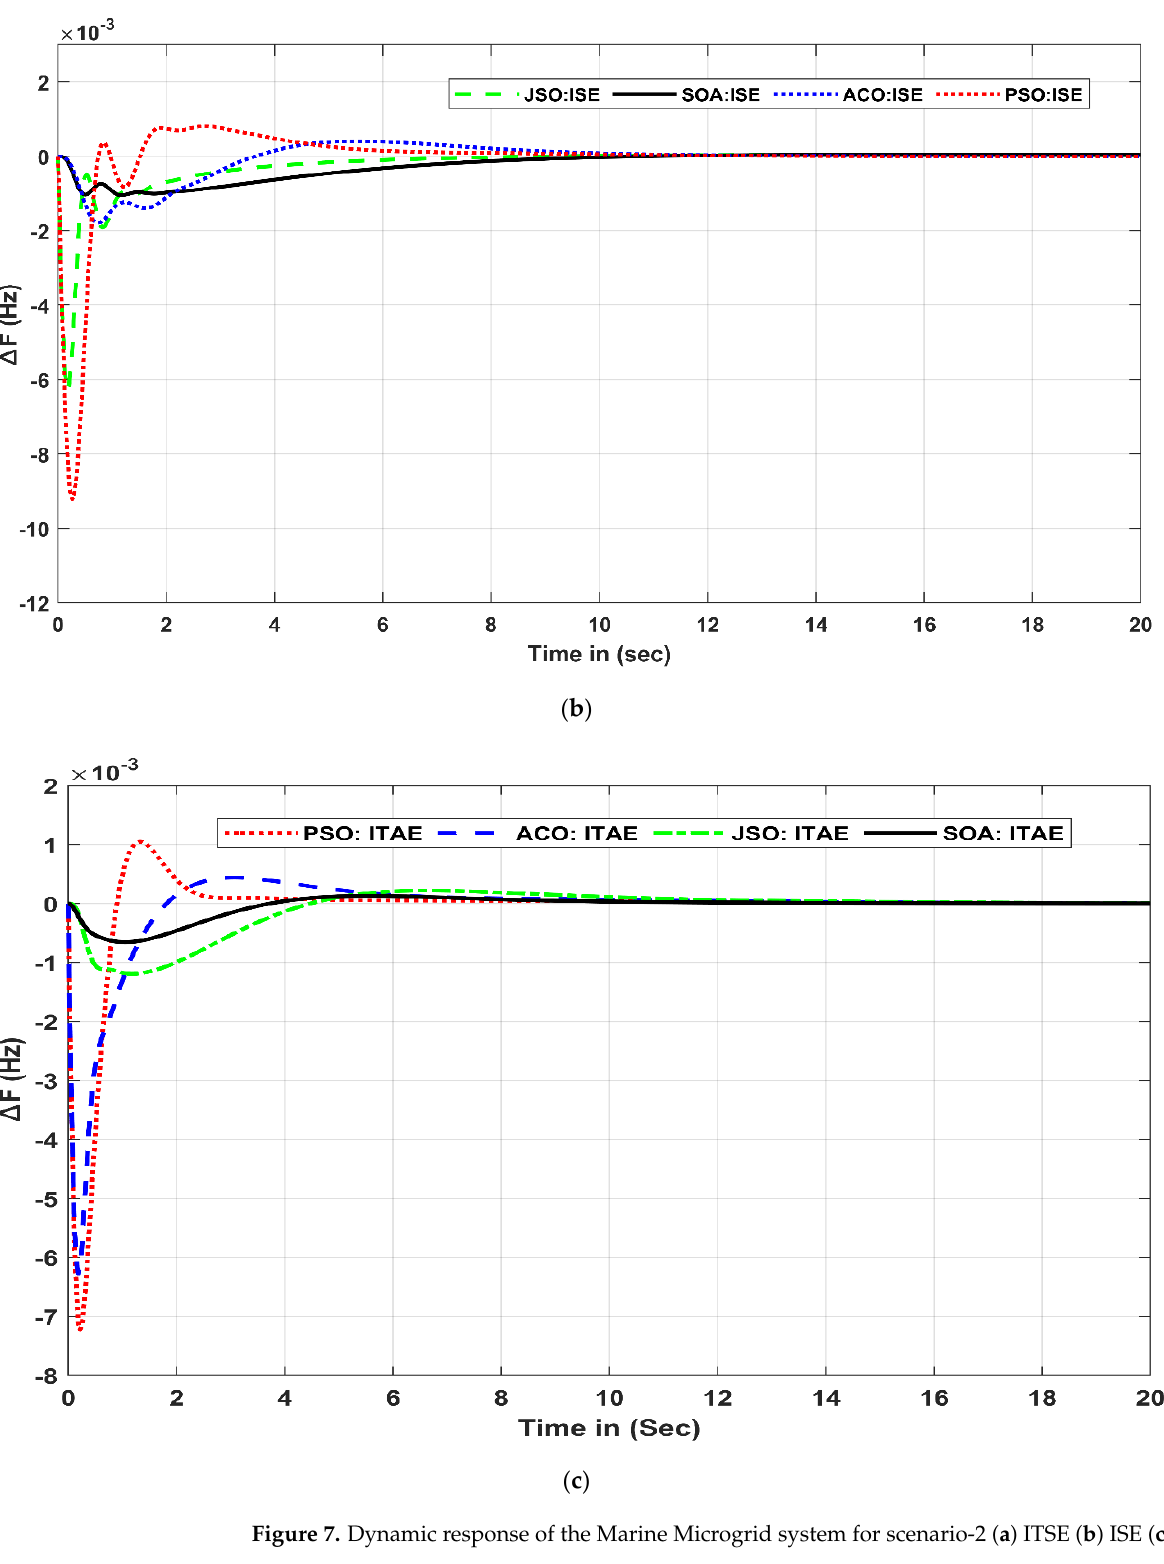
Figure 7. Dynamic response of the Marine Microgrid system for scenario-2 ( a ) ITSE ( b ) ISE ( c ) ITAE. Scenario-3 (Sensitivity and